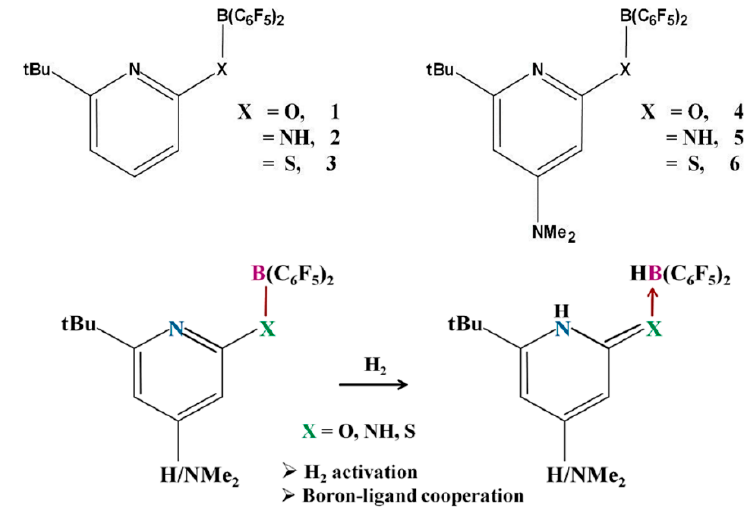
Figure 4. Chemical structure of the bridged FLP systems and the studied reaction.